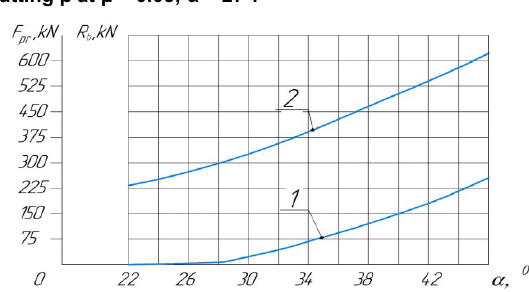
Figure 4. The buffer force (1) and the required press force (2) vs. angle of force transmission to the clamp and the cutting β at μ = 0.05; α = 27°.